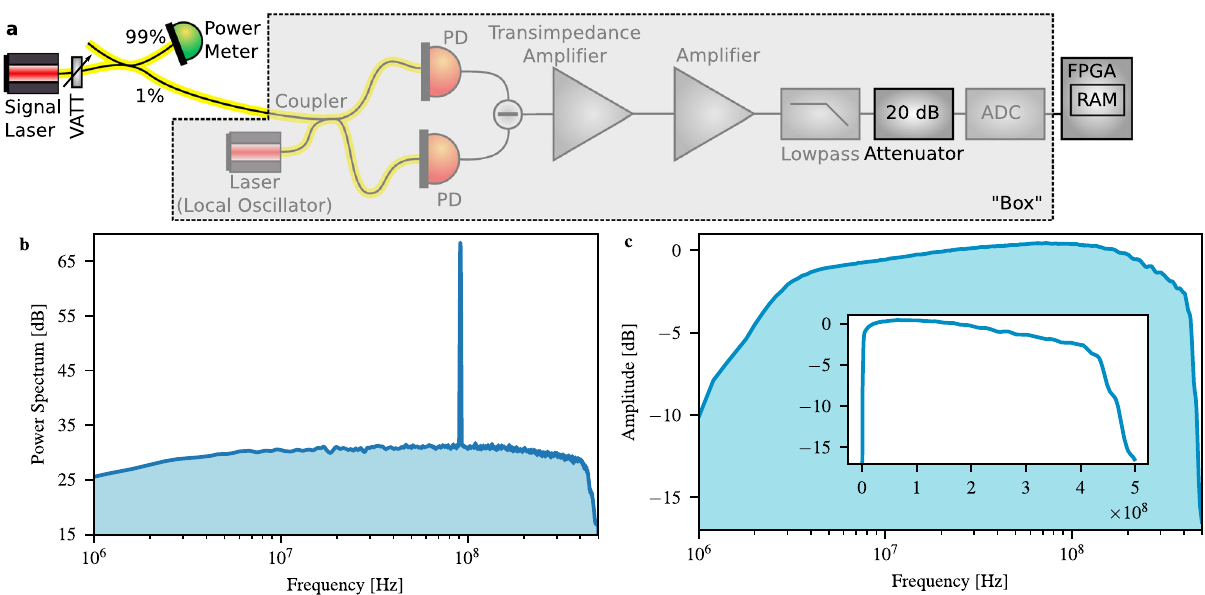
Fig. 3 Characterization of the transfer function of the detection system to obtain the vacuum fl uctuation noise level. a Experimental set-up for the characterization. VATT variable optical attenuator, PD photo diode, ADC analog-to-digital converter, FPGA fi eld-programmable gate array, RAM random access memory. b Power spectrum from a typical measurement. The transfer function is determined by the amplitude of the beat note. c Transfer function of the homodyne detector and the electronics including the analog-to-digital converter. Inset: transfer function with linear frequency scale.